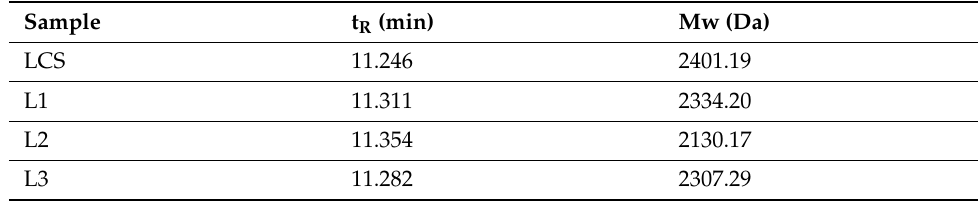
Table 7. Assignment of molecular weights of lignin organosolv from sorghum with and without application of high-power pulses. t R , Retention time at maximum peak intensity; Mw, Molecular weight. Lignin treatment time/amplitude: (LCS) 0/0; (L1) 10/20; (L2) 10/18; (L3)